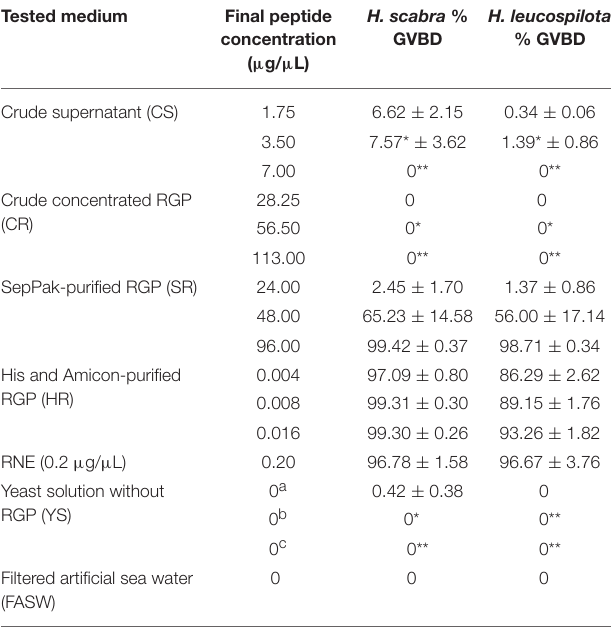
TABLE 2 | GVBD at 3h post-incubation with test medium in Holothuria scabra and H. leucospilota . Tested